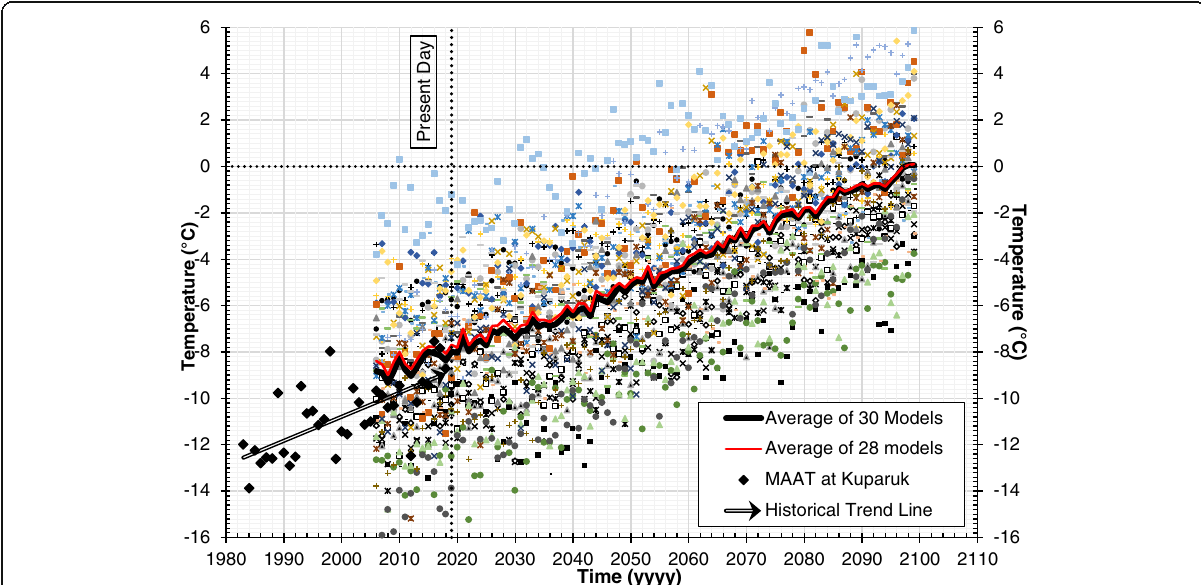
Fig. 3 Historical and predicted mean annual air temperature at the study site. The various colored dots represent 1 of the 30 climate models in this study. The average of all models was used in the thermal modeling